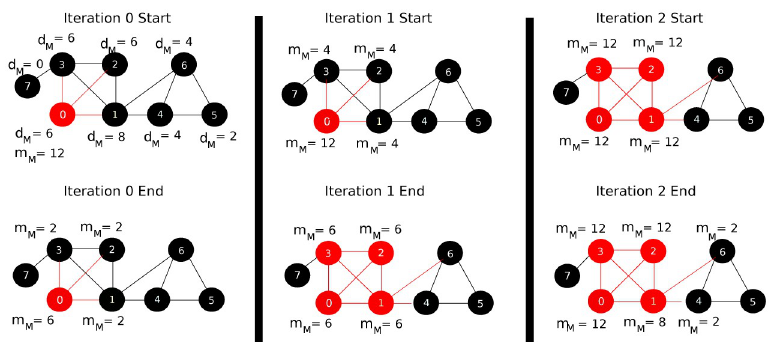
Fig 2. Explanation of hypergraph CRD (HG-CRD) steps on a toy example when we start the diffusion process from node 0 and where each hyperedge (triangle in this case) has a maximum capacity of two. Note that red nodes are nodes with excess of flow, while black nodes are nodes with no excess. At the end, HG-CRD was able to highlight the correct cluster containing nodes 0, 1, 2 and 3.